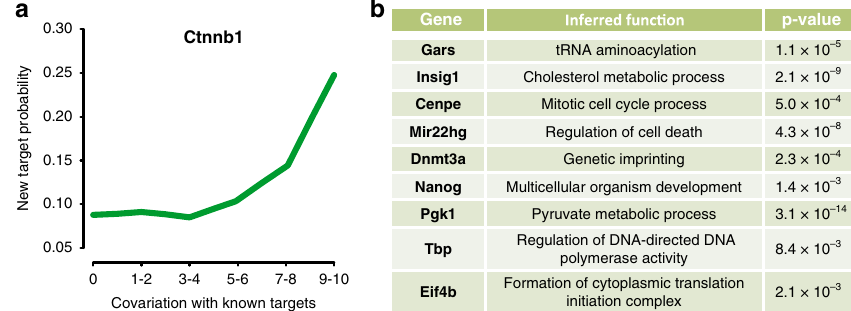
Fig. 5 Gene covariation information can predict regulatory targets. a Genes that covary with transcription factor targets are likely targets of the same factor (Ctnnb1) and can be validated by ChIP-seq. Probability for genes that share a certain number of signi fi cant covariations with the top 100 targets identi fi ed via ChIP-seq to be identi fi ed de novo in an independent second ChIP-seq experiment. b Examples of genes whose canonical function was retrieved purely from the functional annotations of covarying genes ( p -values determined by Fisher ’ s exact